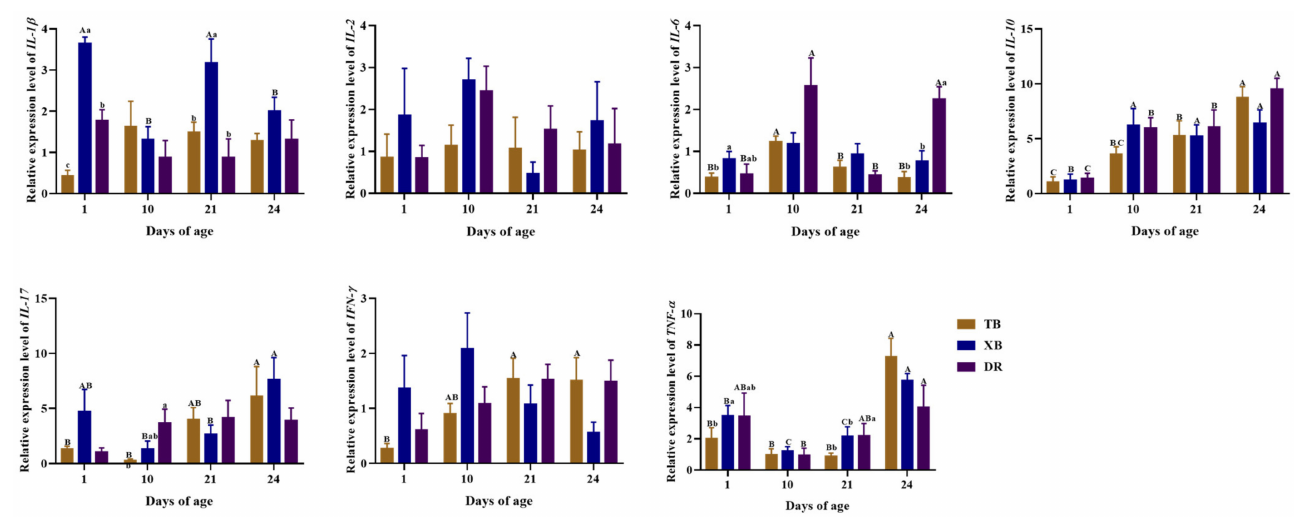
Figure 4. Changes in gene expression levels of ileal immuno-cytokines of different pig breeds during suckling and weaning periods. Data are presented as means with their pooled SEM ( n = 10). Different capital letters (A, B, and C) indicate significant differences between ages in the same breed ( p < 0.05), and different small letters (a, b and c) indicate significant differences between breeds at the same day of age ( p < 0.05). IL, interleukin; IFN- γ , interferon γ ; TNF- α , tumor necrosis factor- α ; DR, Duroc piglet; TB, Taoyuan black piglet; XB, Xiangcun black piglet.